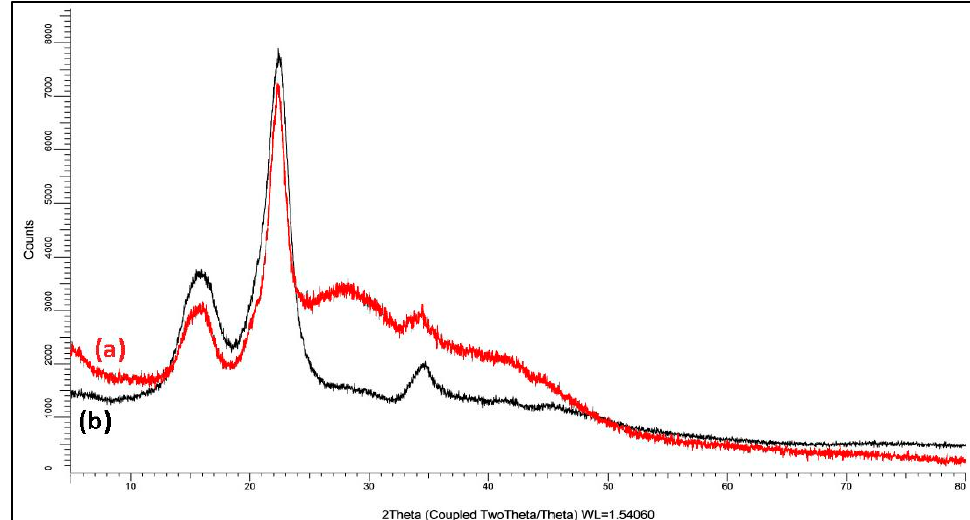
Figure 11. X-ray diffraction patterns of dissolving pulp ( a ) whole-empty fruit bunches (WEFB) and ( b ) stalk-empty fruit bunches (SEFB).